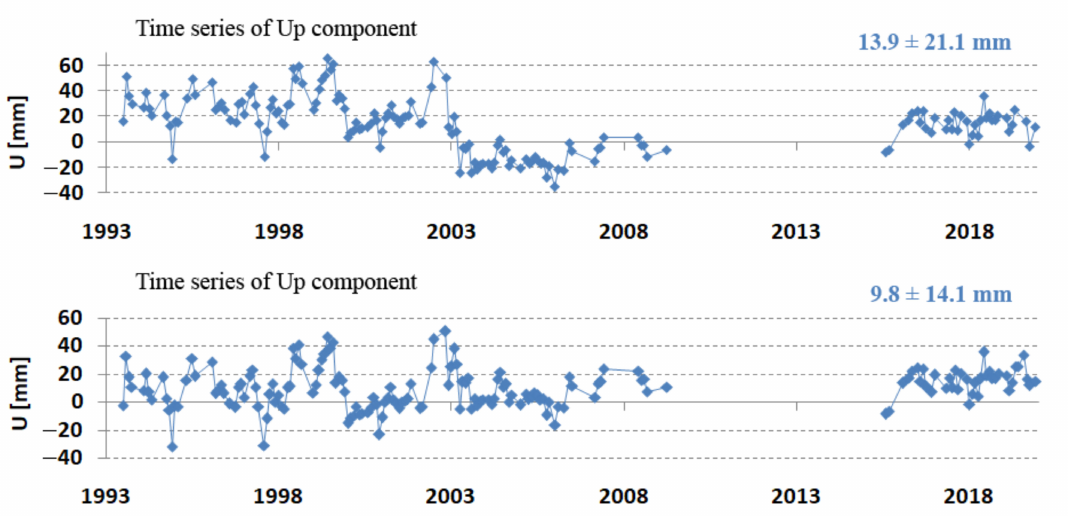
Figure 9. Borowiec SLR station—vertical component consistent with the ITRF2014 coordinate jump ( top ) and after the ITRF2014 data conversion ( bottom